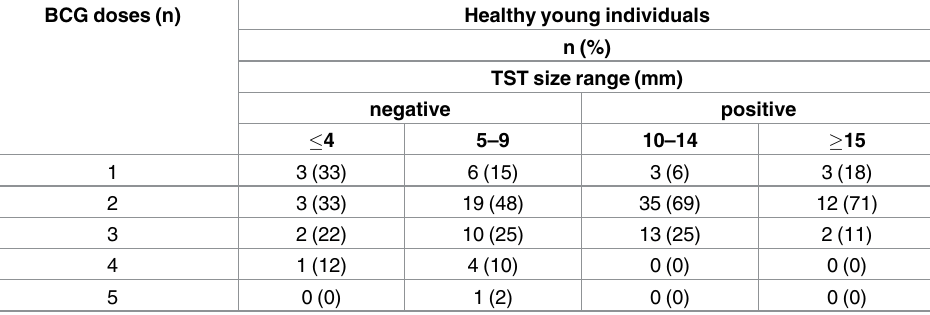
Abbreviations: BCG, Bacille Calmette-Gue´rin; TST, tuberculin skin test